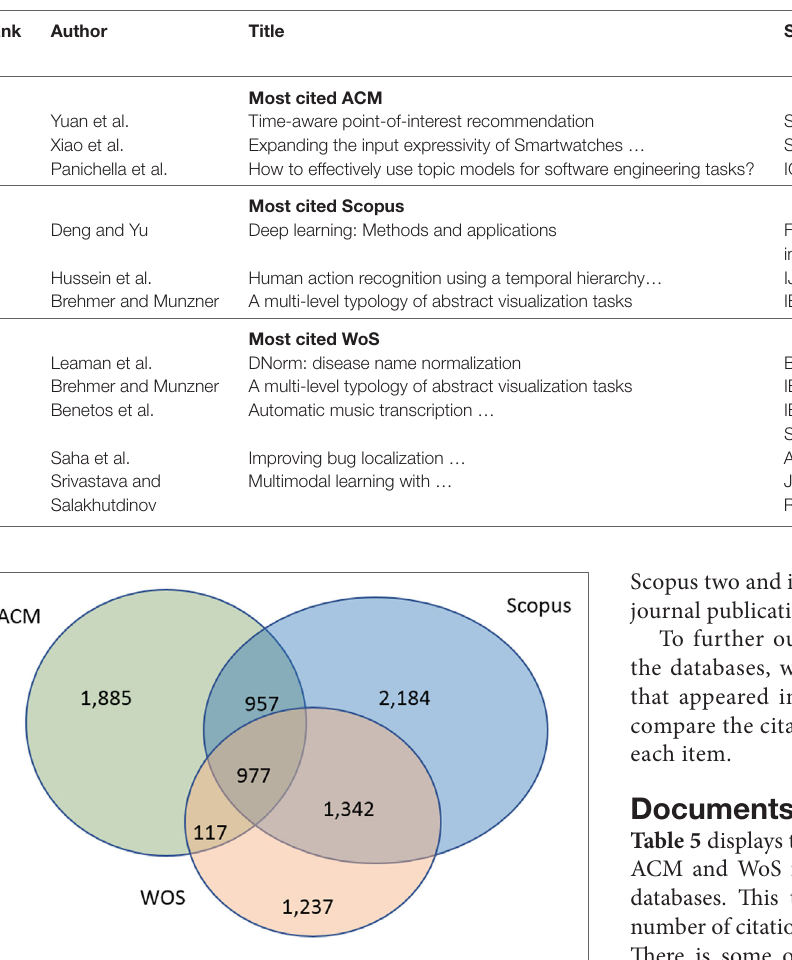
taBlE 4 | Top-cited documents by database.